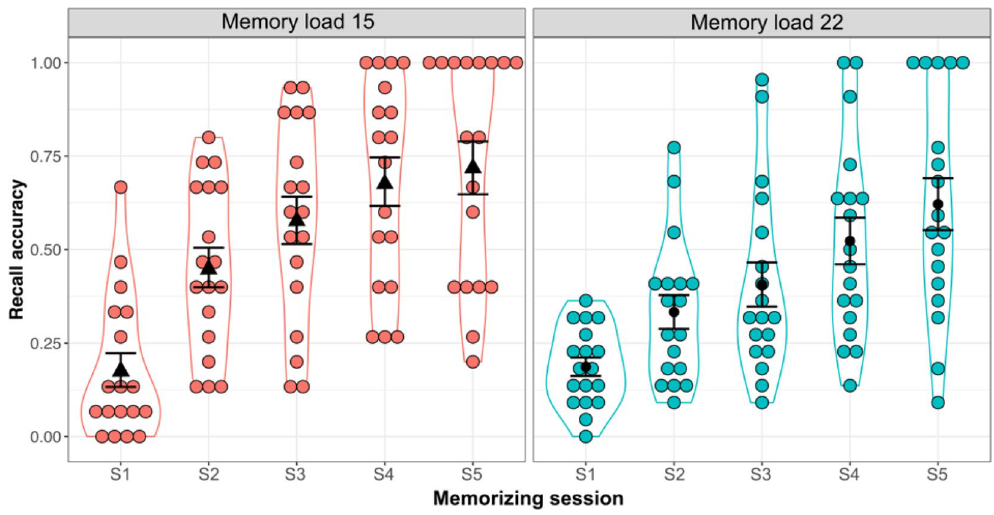
Figure 2. Mean recall accuracy as a function of memory load and memorizing session. Black triangles and dots represent mean recall accuracy in the memory load 15 and 22, receptively, following every memorizing session. Jittered dots in red are recall accuracy for each user in the memory load 15 and the dots in green are individual recall accuracy in the memory load 22. Error bars indicate the standard error of the mean.